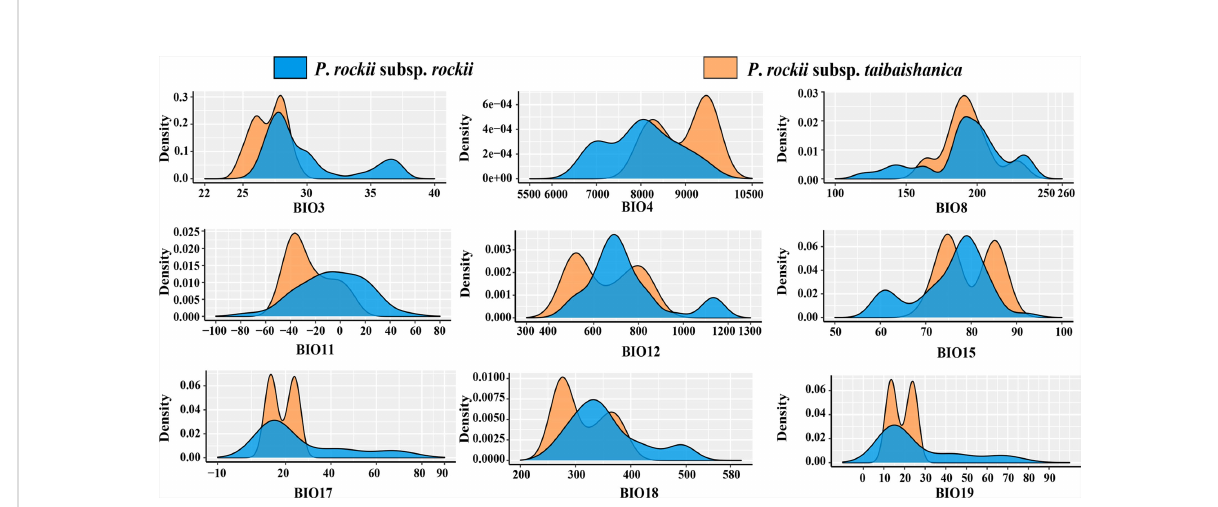
FIGURE 4 Kernel density plots of nine climatic variables for two subspecies of P . rockii .